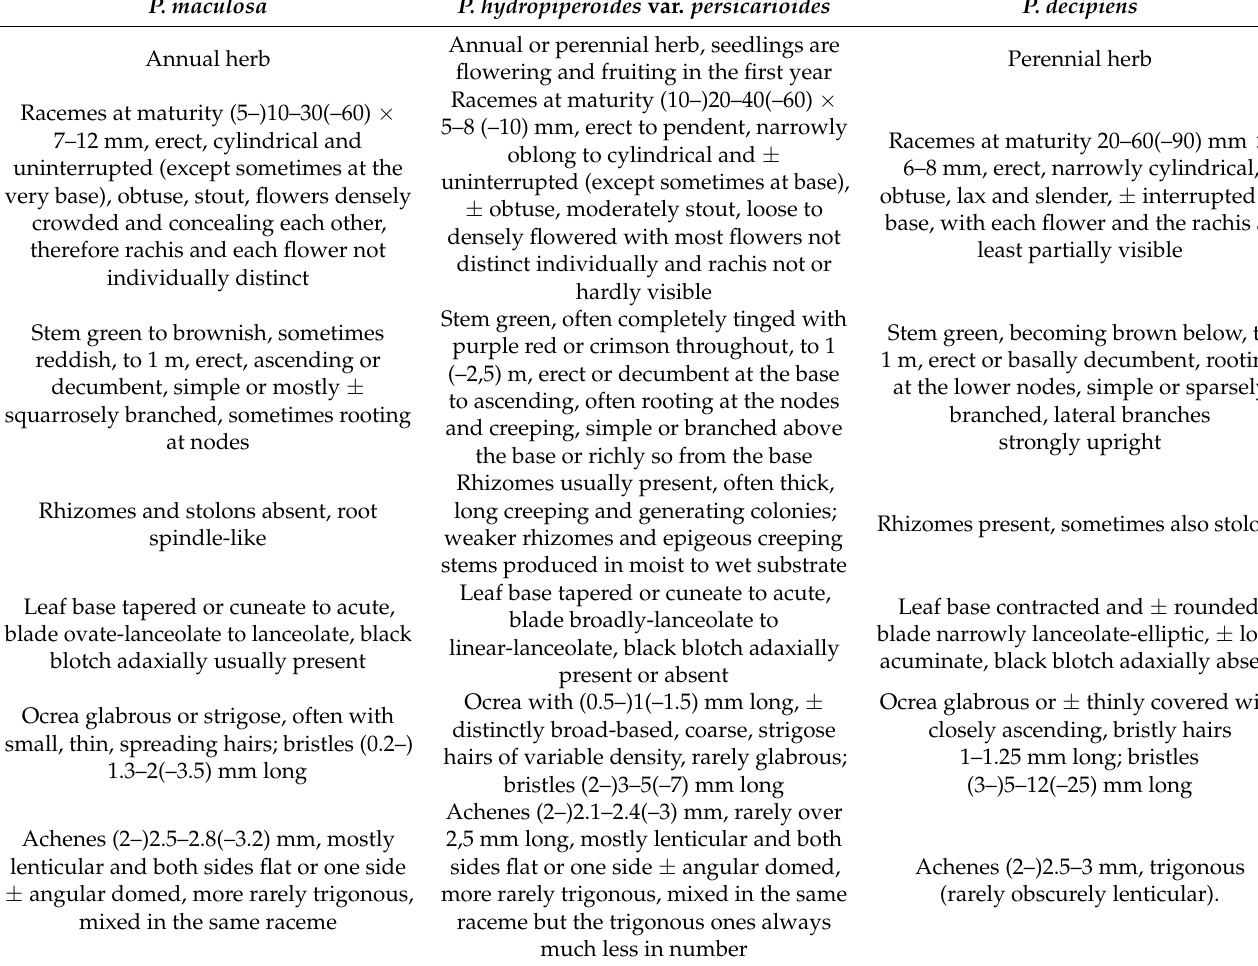
Table 2. Differentiating features between the two very variable species Persicaria maculosa and P. hydropiperoides (var. persicarioides ), and P. decipiens . Data are based on our own observations as well as modified from [47–52]. When using the table, it should be noted that some characteristics can be very differently pronounced in a single specimen of a taxon, are therefore difficult to quantify and may overlap when comparing two